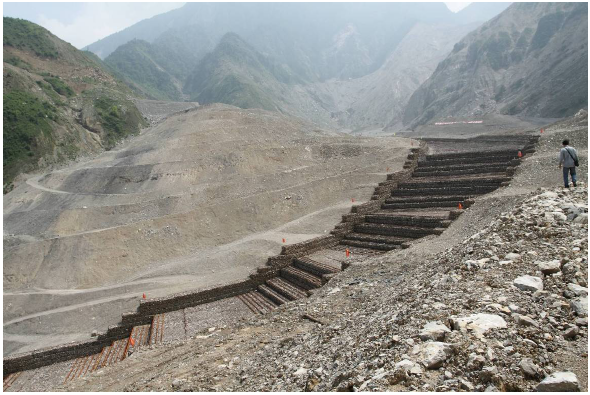
Fig. 22. A flexible erosion prevention system constructed in the Wenjia gully.